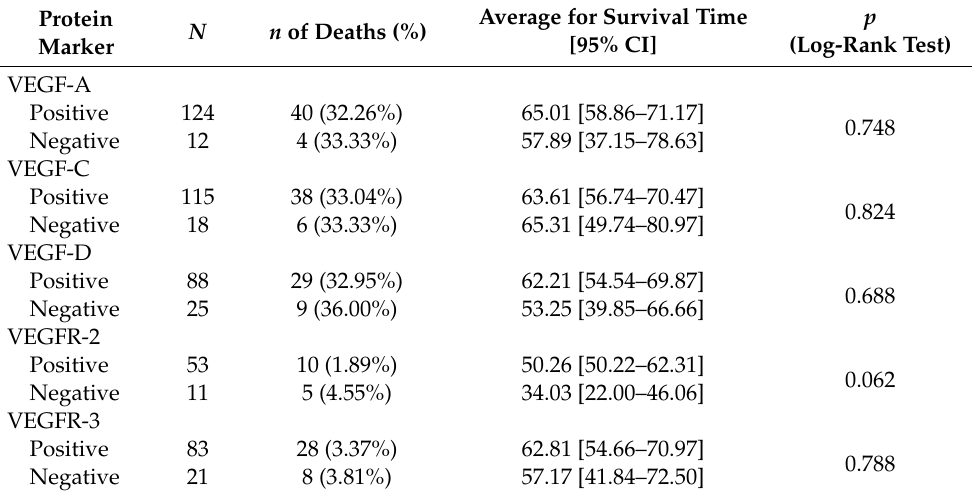
Table 8. Relation between VEGF expression in CRC lymph node metastasis and